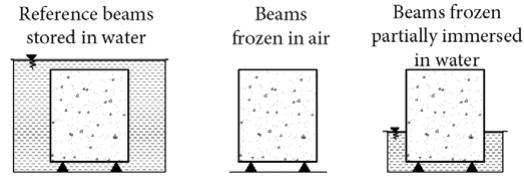
Fig. 2. Different storing method of concrete samples during freeze-thaw tests